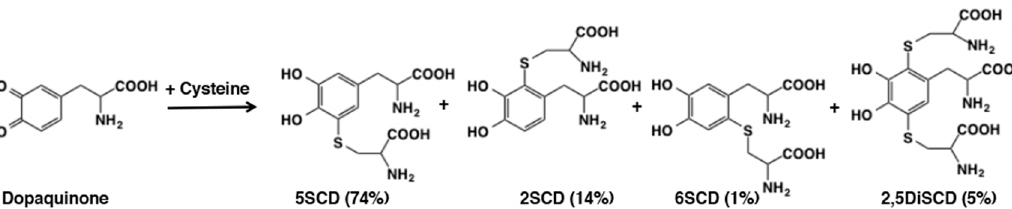
Figure 5. Reaction of dopaquinone with cysteine. 5- S -Cysteinyldopa (5SCD) is the major isomer [26] and serves as a biochemical marker of malignant melanoma [28].